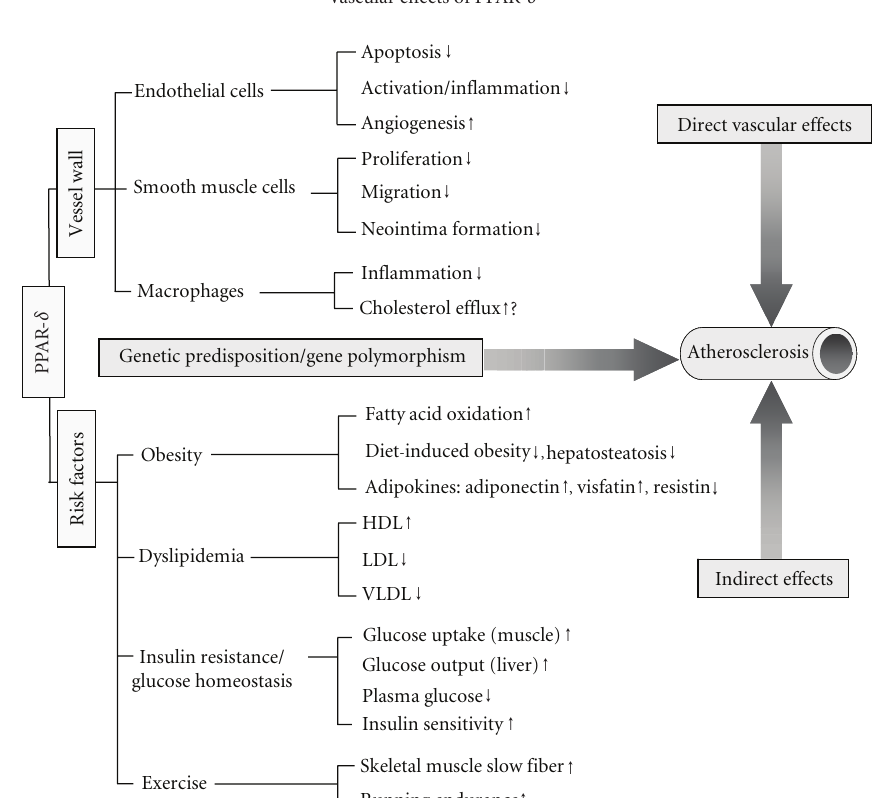
Figure 1: Activation of PPAR- δ may have profound e ff ects on vascular homeostasis and coronary artery diseases. These include both the direct actions in the vessel wall and the indirect e ff ects on multiple cardiovascular risk factors. PPAR- δ gene polymorphisms are also linked to cardiovascular